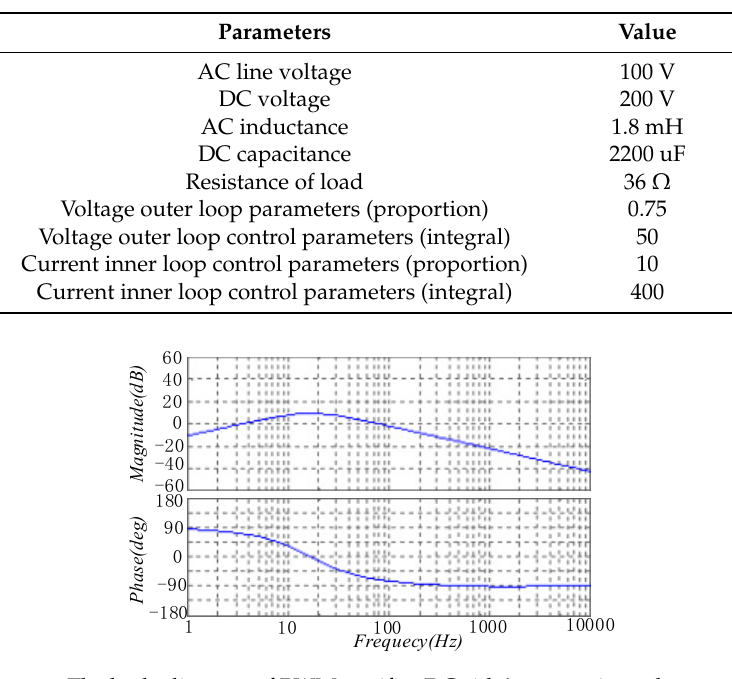
Figure 12. The bode diagram of PWM rectifier DC side’s output impedance Figure 12. T he bode diagram of PWM rectifier DC side’s output impedance model.